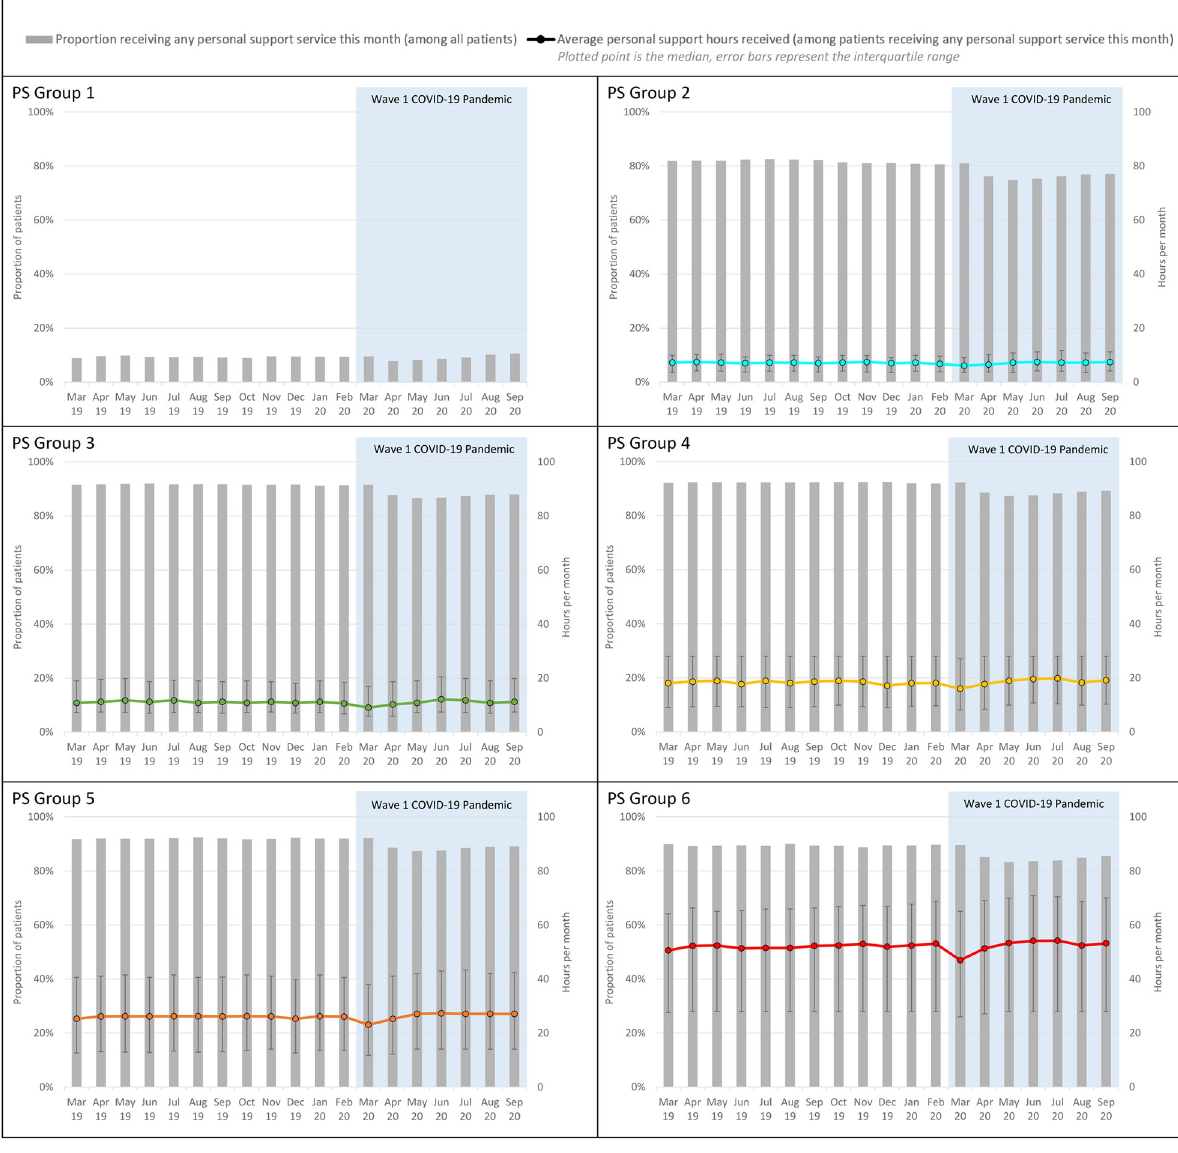
Fig 3. Receipt of personal support services among patients assessed with comprehensive assessment, by personal support algorithm.